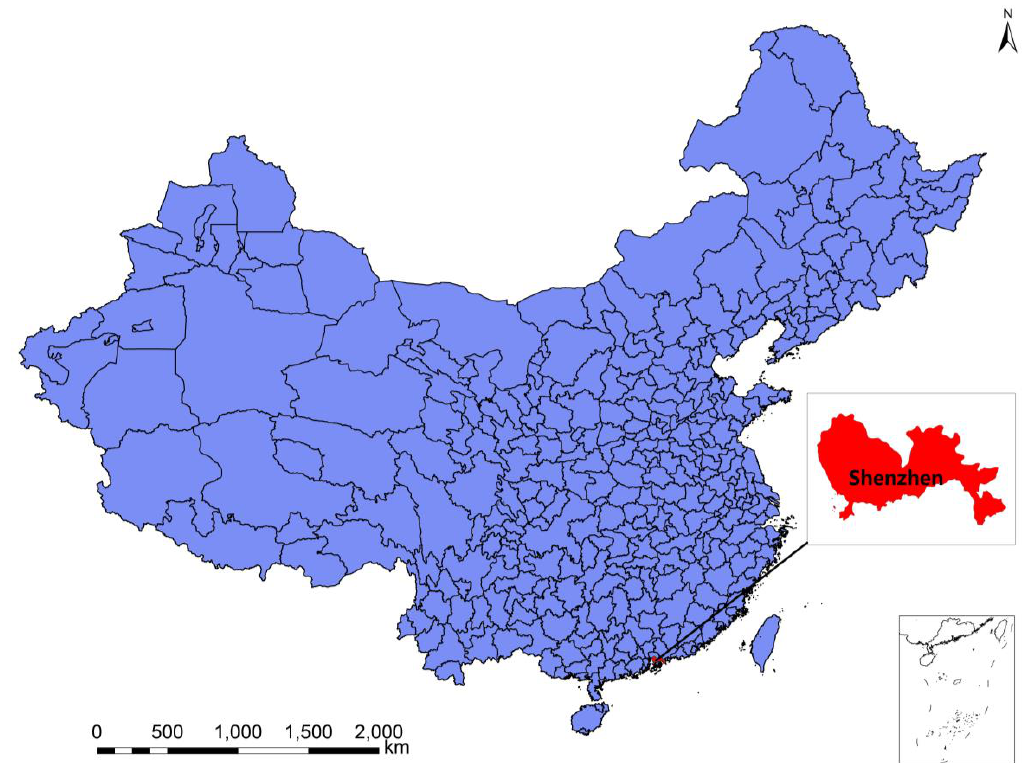
Figure 1. Location of Shenzhen in China.